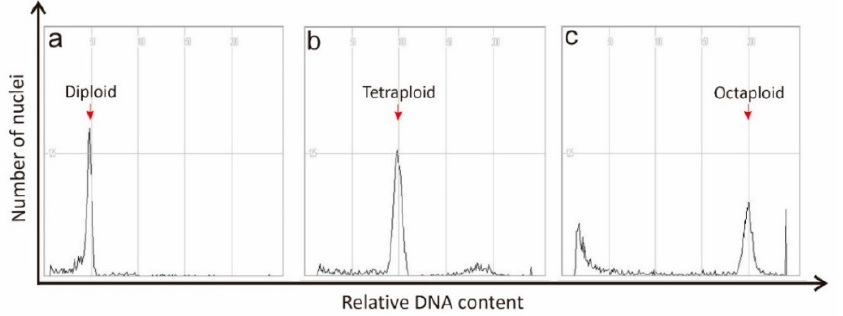
Figure 2. Histograms show the flow cytometry analysis of comparative changes in ploidy levels in watermelon. ( a ) Diploid (2 n = 2 x = 24), ( b ) tetraploid (2 n = 4 x = 48), and ( c ) octaploid (2 n = 8 x = 96). Red arrows indicate ploidy levels of diploid, tetraploid and octaploid.